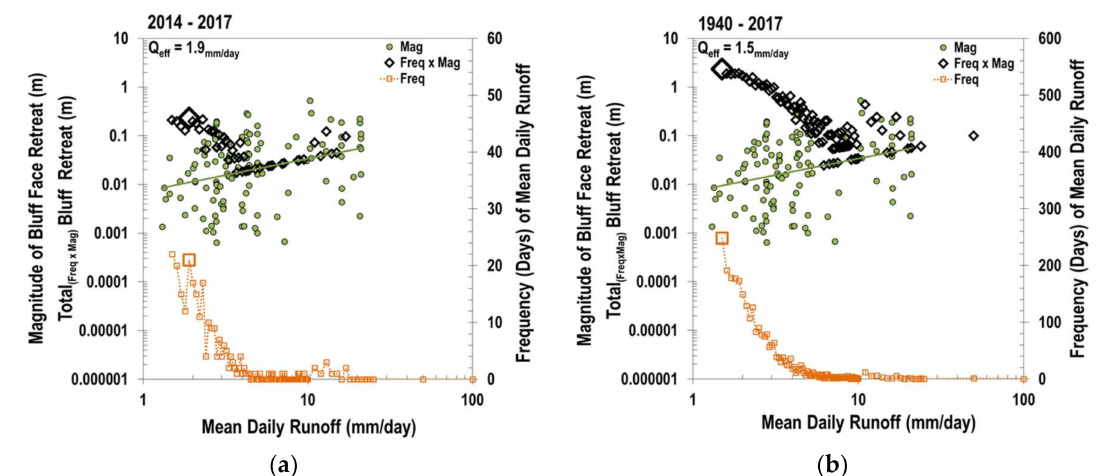
Figure 8. Streamflow frequency, days greater than 1.5 mm/day runoff (orange); bluff erosion magnitude, given the bluff erosion ( E )-discharge ( Q ) power law relation E = 0.01 Q 0.67 (green line fitted through green points); and the product of bluff erosion magnitude and streamflow frequency versus river basin runoff (mm/day), during the periods ( a ) 2014–2017 and ( b ) 1940–2017. Mean daily runoff values for the Le Sueur River gage near Rapidan, MN (USGS